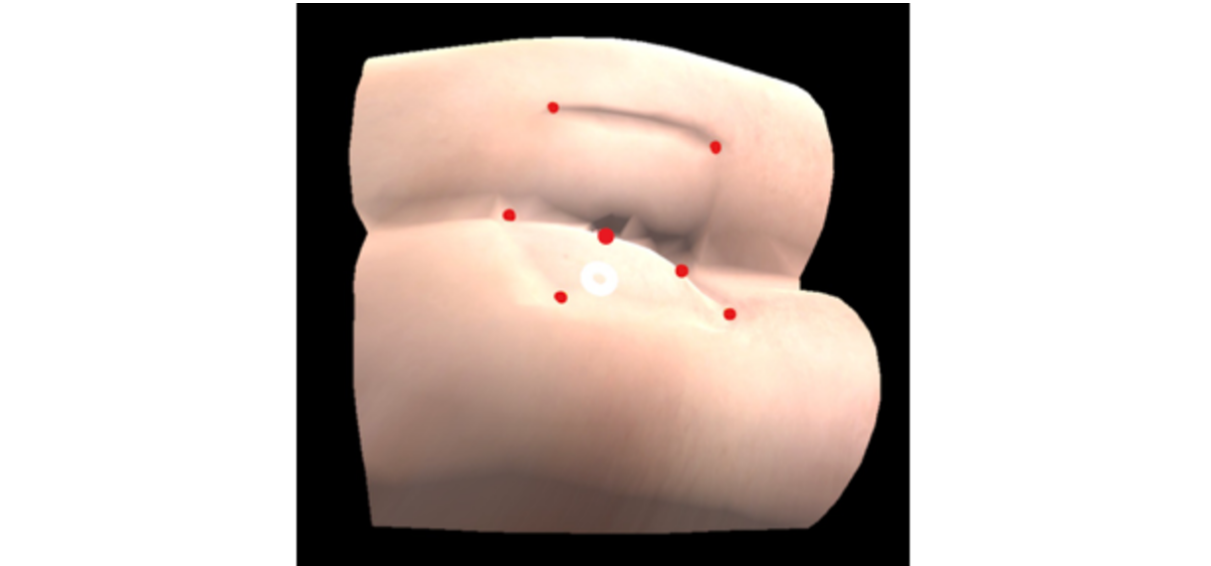
Figure 7. Red landmarks on a benchtop model used as inputs to the iterative closest point algorithm.